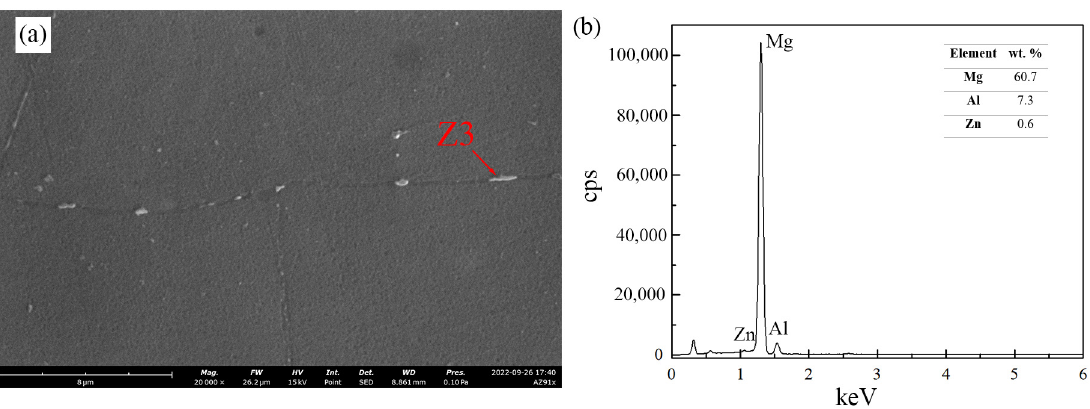
Figure 4. SEM micrograph of β -Mg 17 Al 12 bulk precipitates found at grain boundaries of non-treated material after aging at 175 °C for 1440 min; ( b ) EDS analysis of the Z3 particle identi fi ed in ( a ).